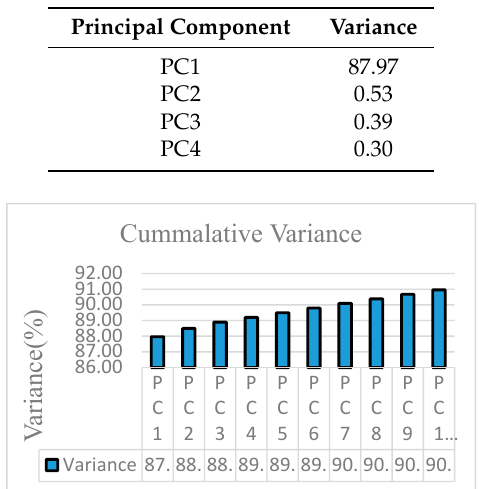
Table 2. Variance of individual principal components (PCs).